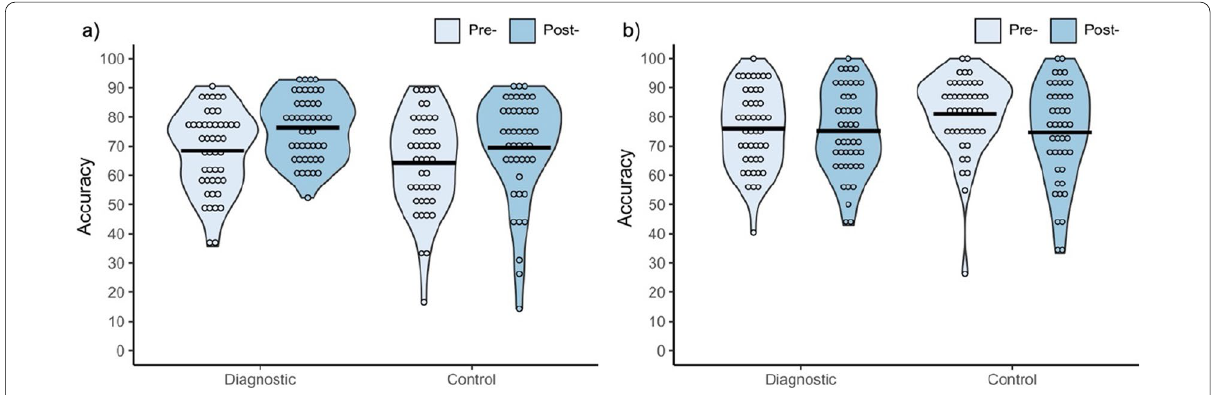
Fig. 3 Accuracy (%) on the EFCT for both training conditions on a) match trials b) and mismatch